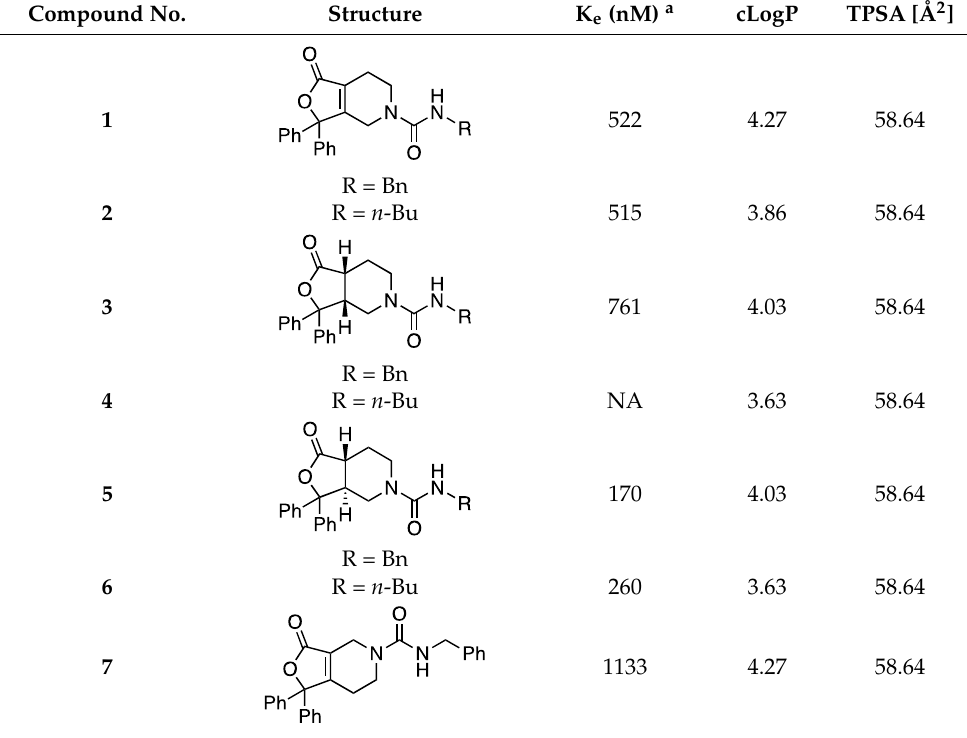
Table 1. Modifications of the core oxazolidinone ring. Compound No.